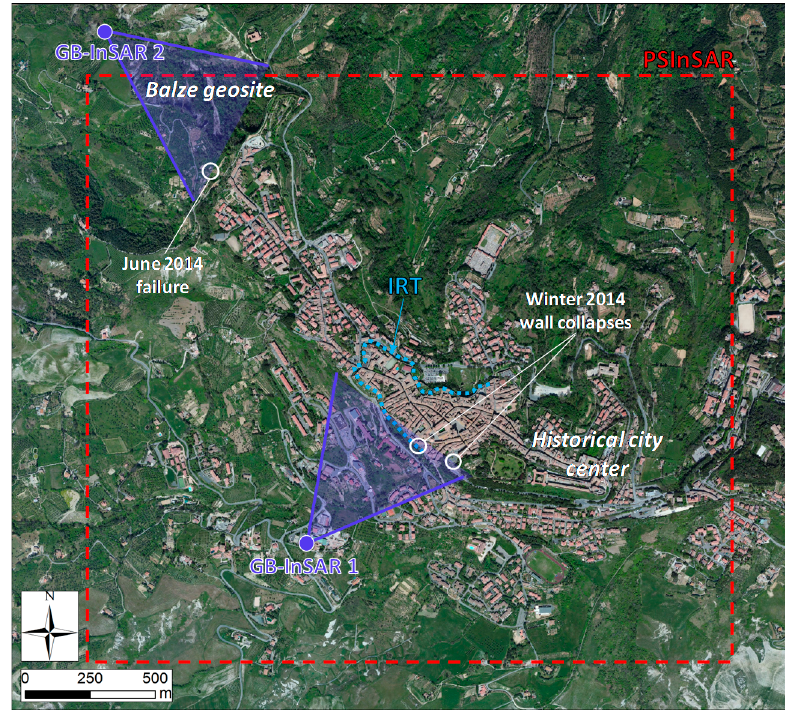
Figure 4. PS-InSAR-analyzed area (red dashed square). GB-InSAR system location and monitored areas (violet triangles) (GB-InSAR-1 system monitoring the mediaeval walls, GB-InSAR-2 system monitoring the slope instability phenomena in correspondence of Balze Geosite). IRT-surveyed wall sectors (dashed blue line). Table 1. Characteristic of the employed technologies. Date format: dd/mm/yyyy.